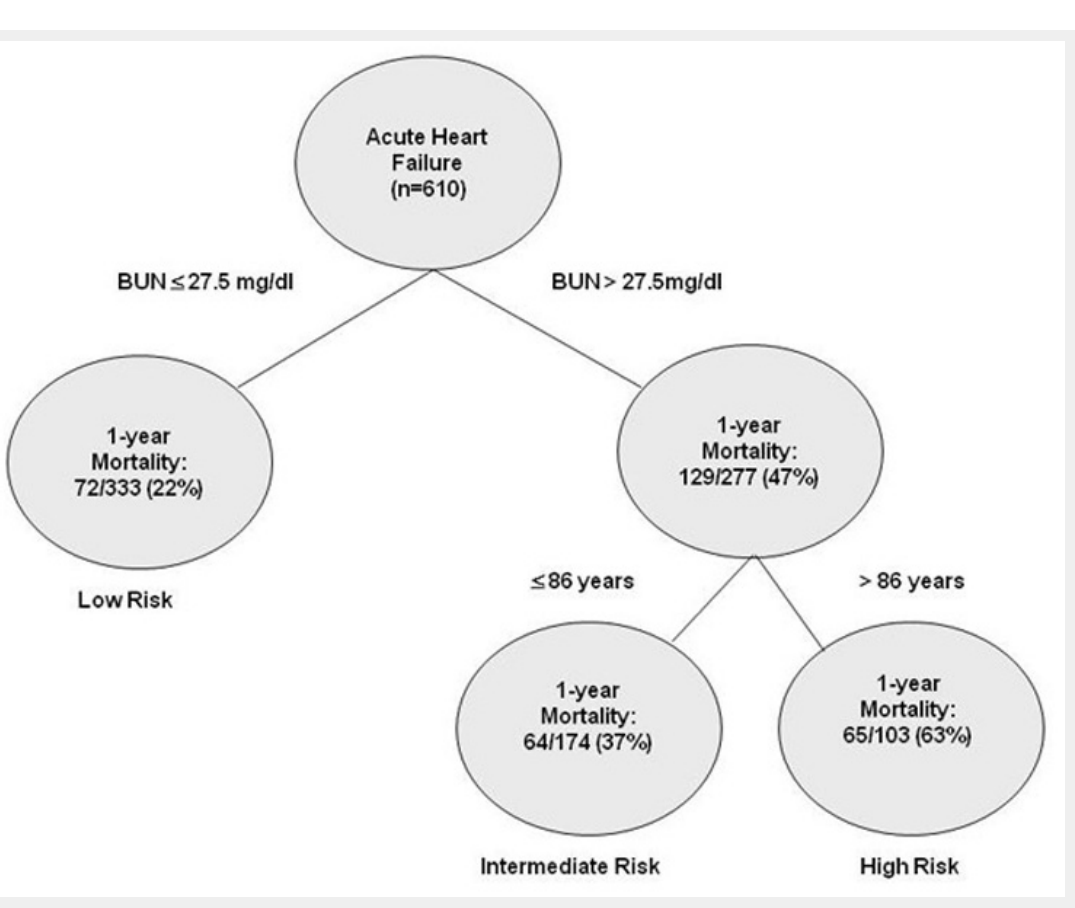
Risk Stratification Algorithm of AHF Patients regarding 1-year Mortality. Risk groups: High risk group (BUN >27.5 mg/dl and age >86 years), intermediate risk group (BUN >27.5 mg/dl and age £86 years) and low risk group (BUN £27.5 mg/dl); each node is based on available data from patients presenting to the